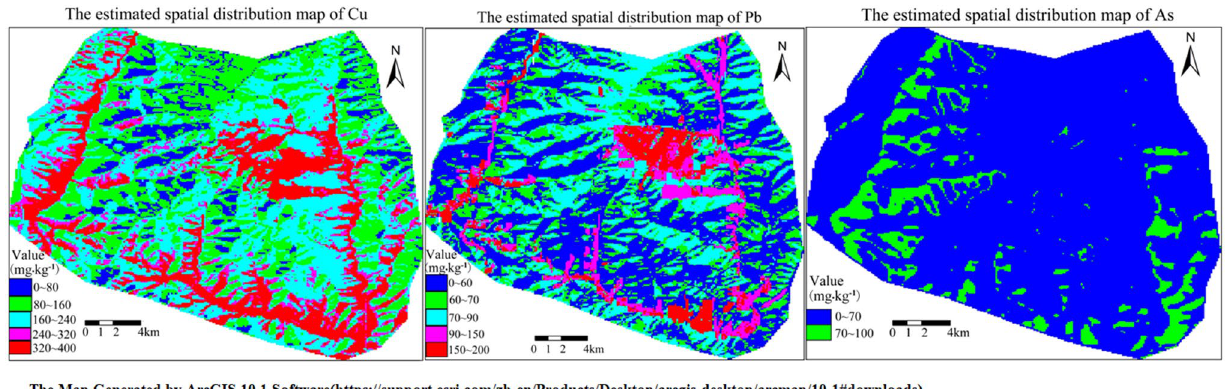
Figure 2. Spatial distribution maps of the concentrations of ( a ) Cu, ( b ) Pb, and ( c ) As in soils in the study area.